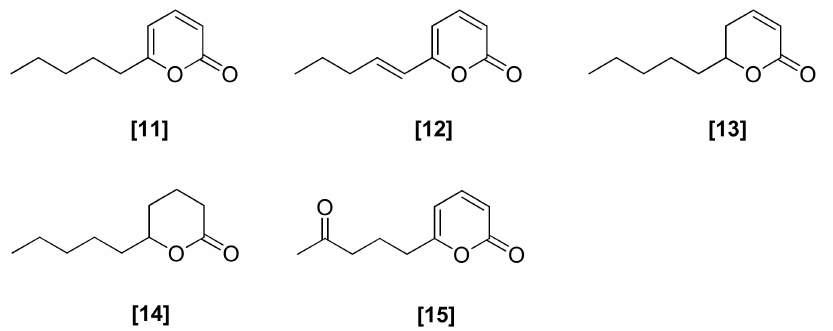
Structures of antifungal pyrones from Trichoderma spp.: [11] 6-PP isolated from T. viride ; [12], [13], [14], and [15] analogues of 6-PP isolated from T.